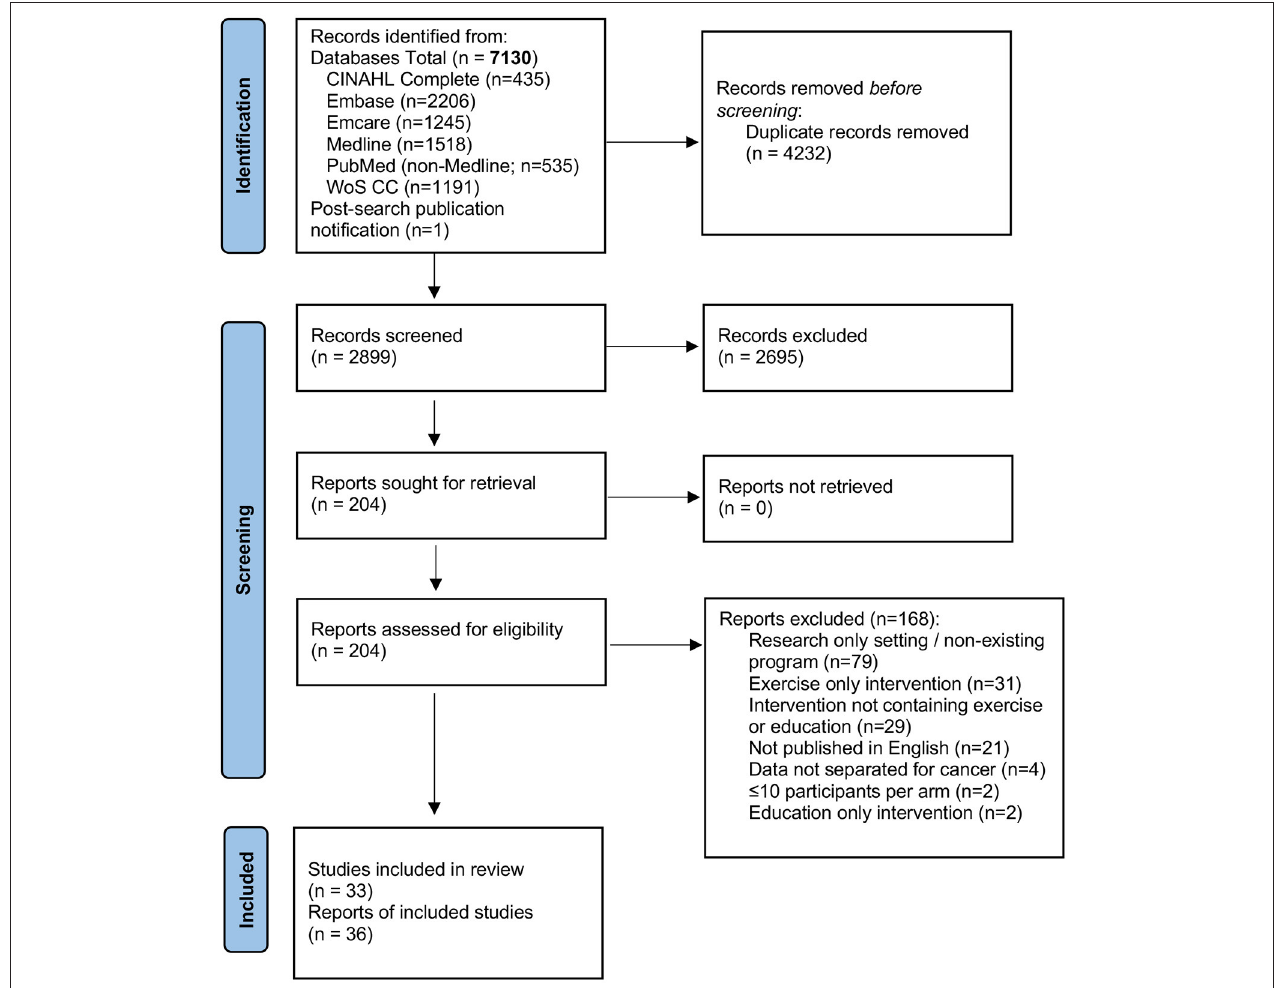
FIGURE 1 | PRISMA flow